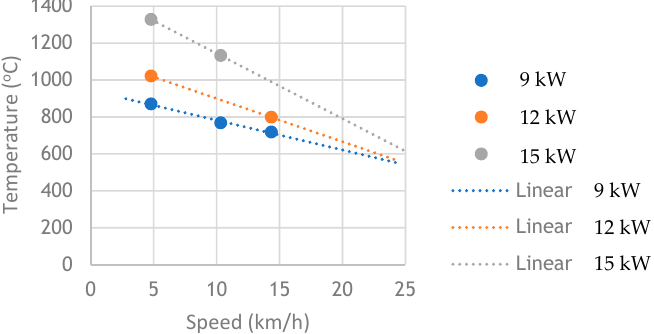
Figure 11. On-track testing: railhead peak surface temperature vs. DMU speed and microwave forward power. φ int = 3 mm, N 2 = 20 L/min (solid dots—measured temperature, broken line—extrapolation of temperature trend vs. increasing speed).